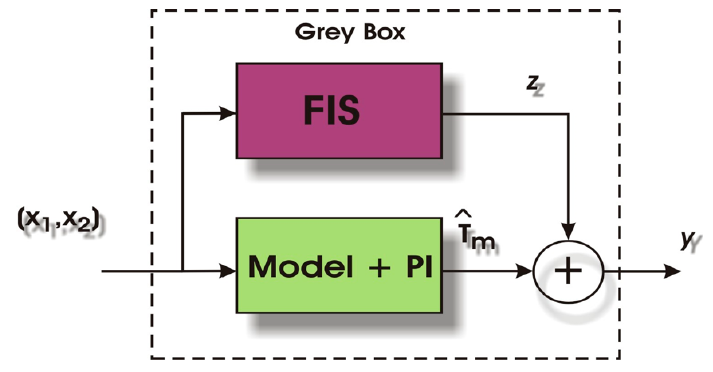
Figure 4. Parallel Grey-box scheme.